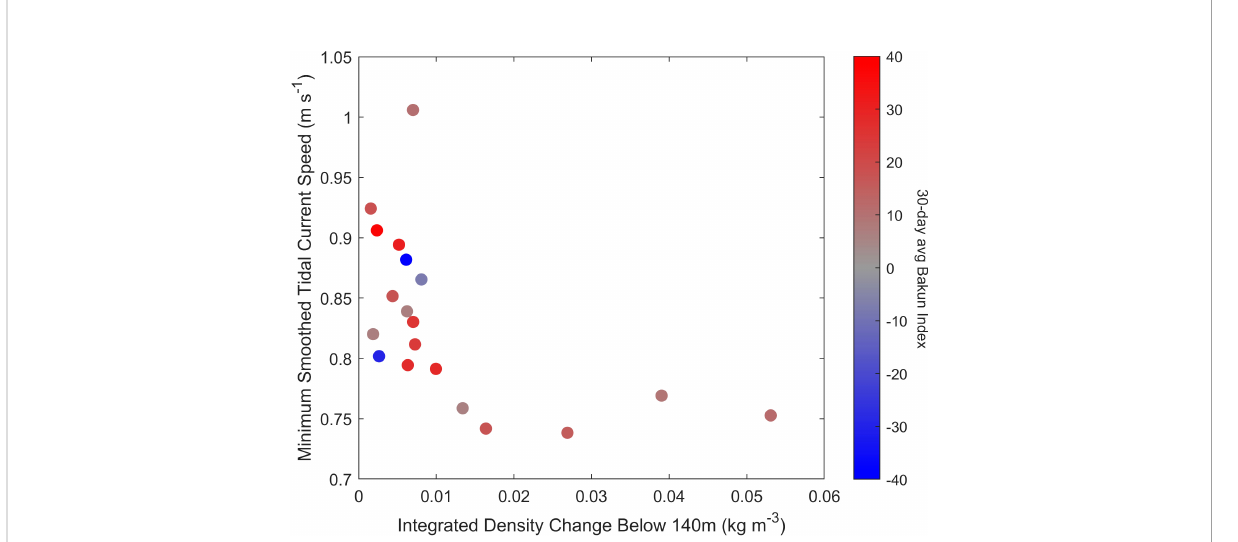
FIGURE 4 The minimum in the smoothed tidal current speed vs . the potential strength of a renewal event (change in potential density ( D s q ) below 140m observed through CTD casts in Saanich Inlet). Each renewal event is coloured by the average of the Bakun Index over the 30 days prior to the minimum smoothed tidal current speed.